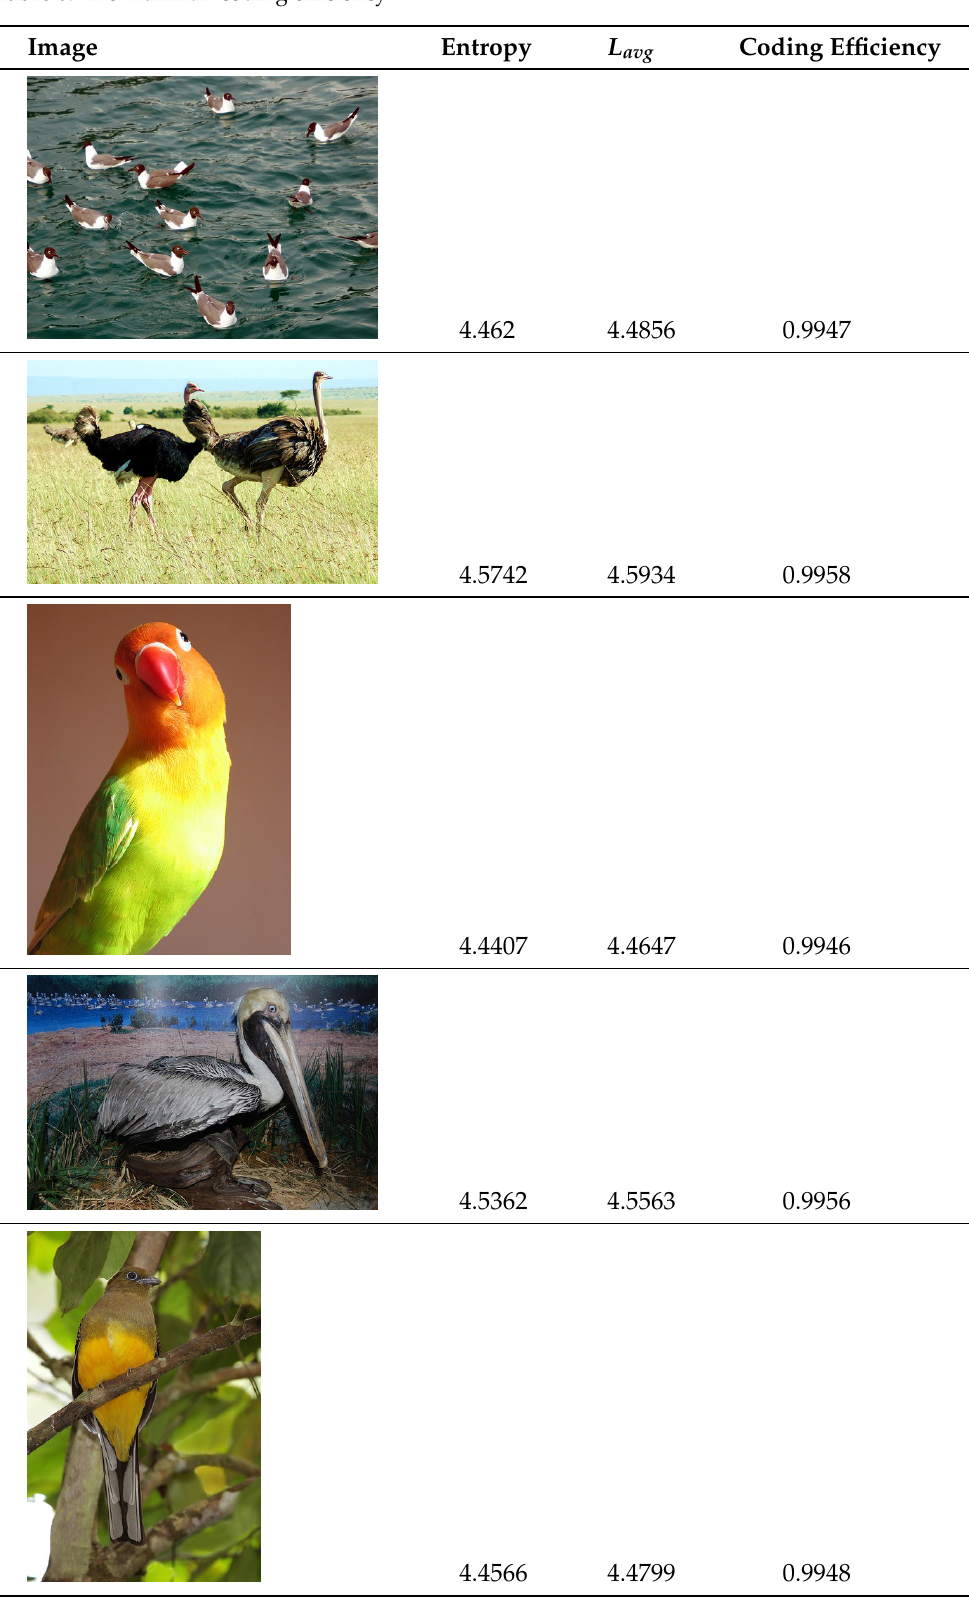
Table 6. The Huffman coding